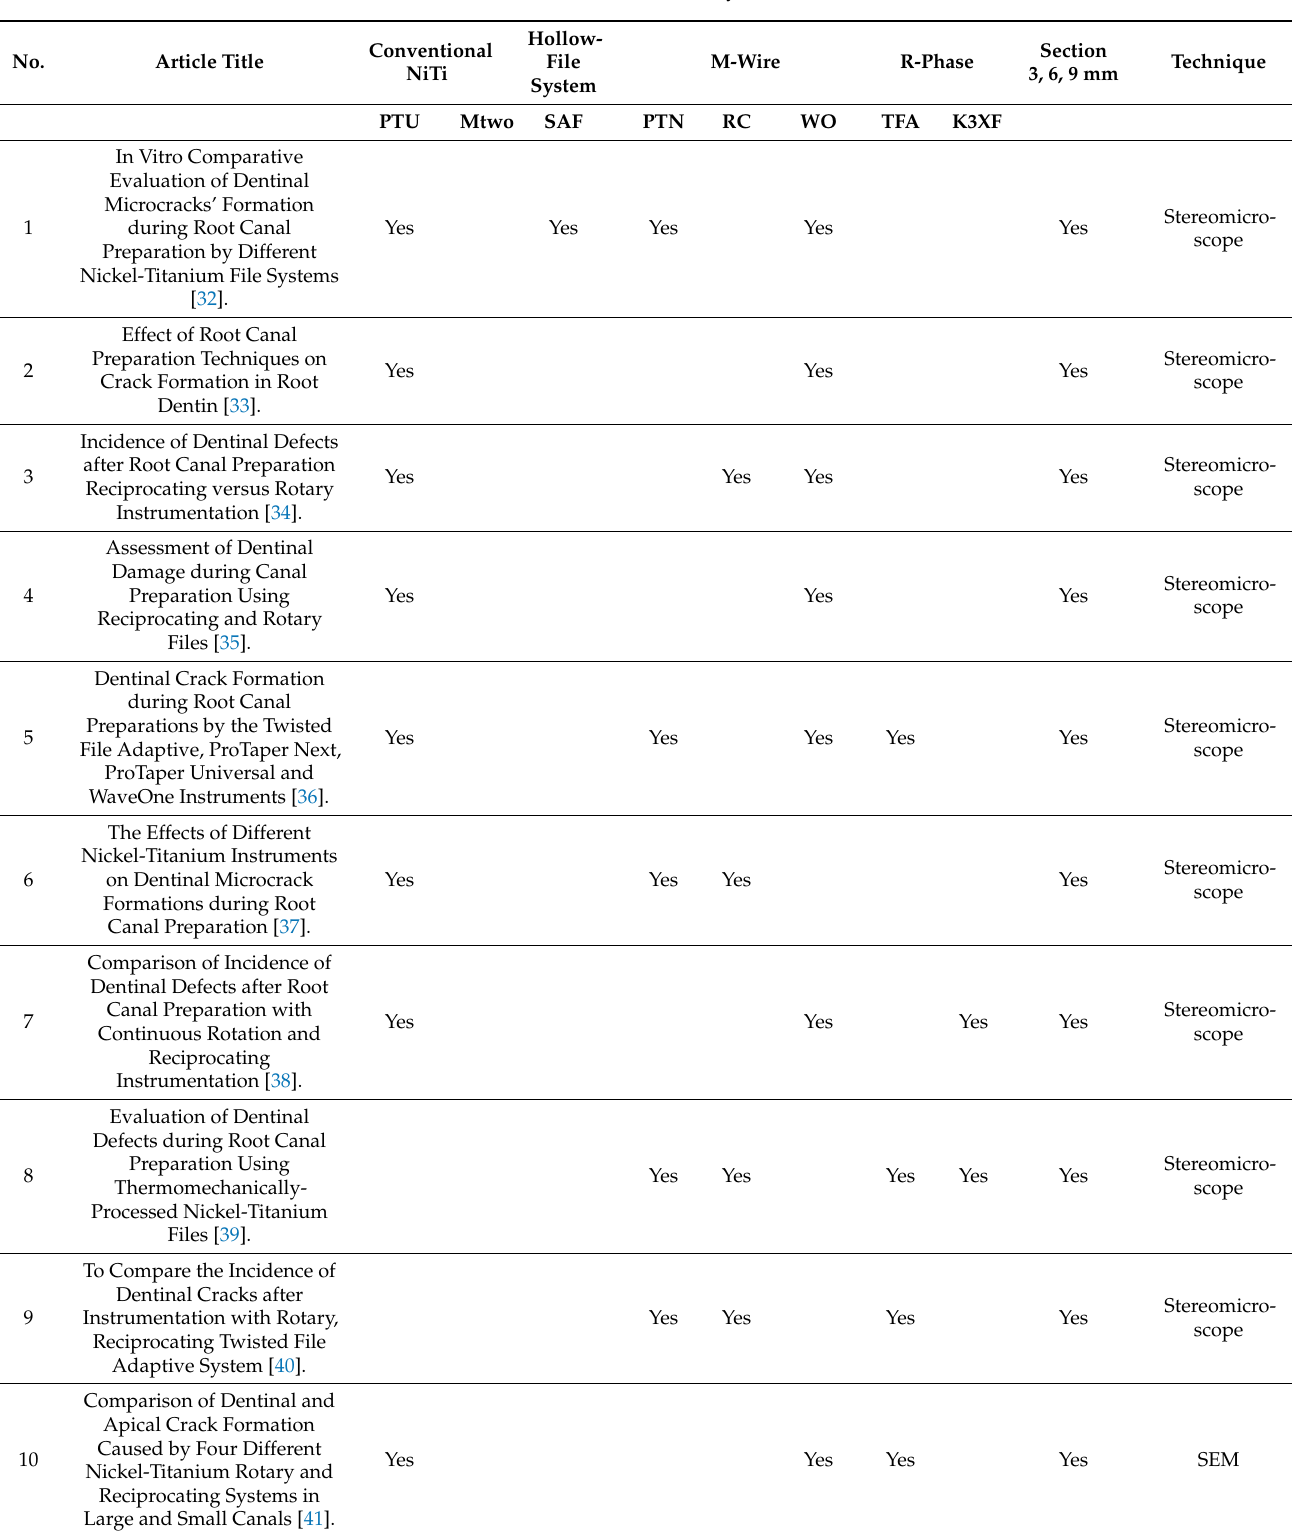
Table 3. Articles included in the systematic